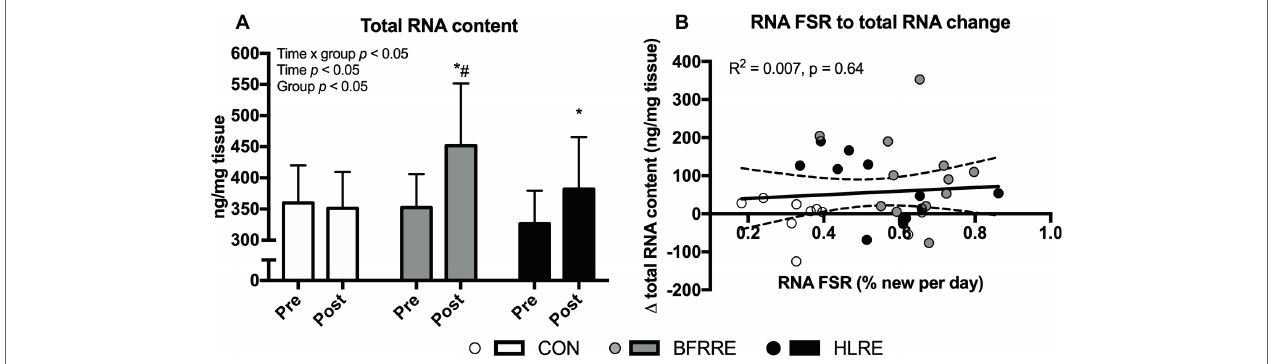
FIGURE 4 | Total RNA content at baseline (pre) and 4 days after cessation of training (post) (A) . Correlation between RNA synthesis and change in total RNA content. Data are presented as mean ± SD in (A) . In (B) , data are presented as individual values and a linear regression line (solid) with 95% CI (dashed). Overall effects are given in the upper left corner of graphs (A) . R square and significance is given in the upper left corner of (B) . * p < 0.05 different from pre within group; # p < 0.01 different from CON.